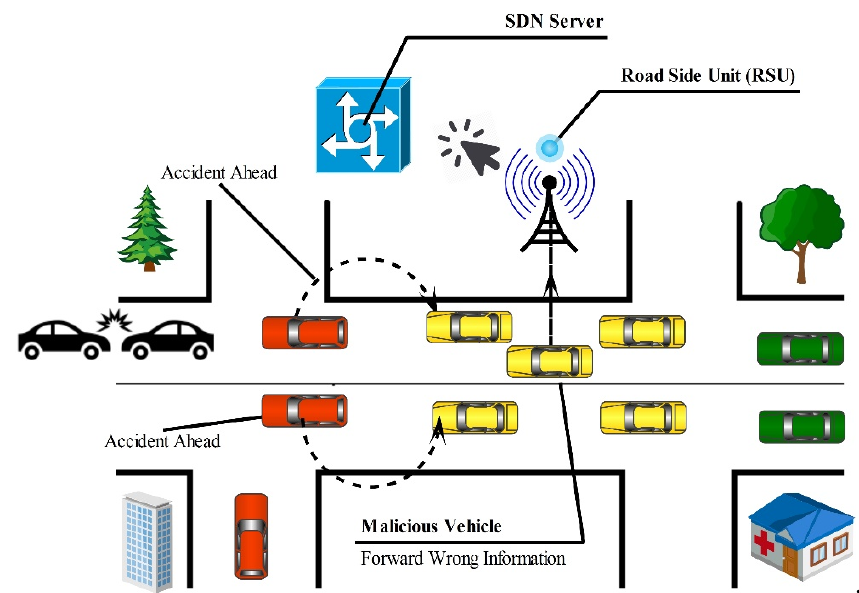
Figure 16. Black hole attack in SDN-based VANETs.